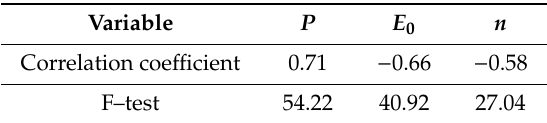
Table 1. Regression analysis results of runoff ( R ) with precipitation ( P ), potential evapotranspiration ( E 0 ), and catchment parameter ( n ), respectively.